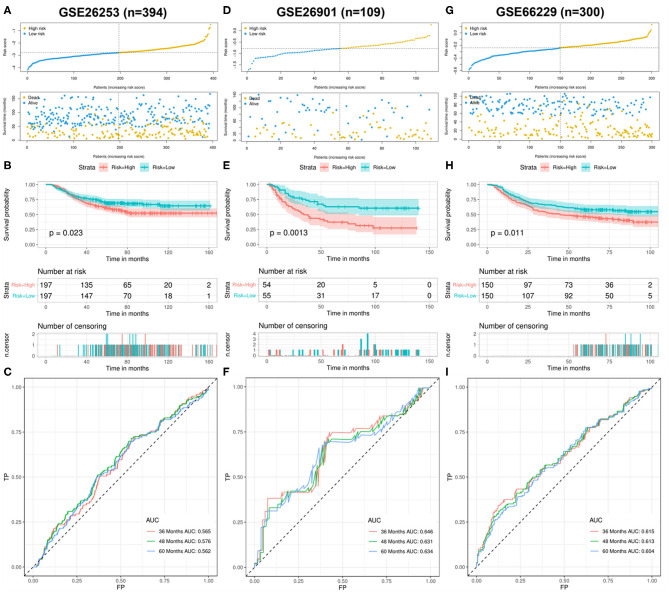
External validation of the prediction model using expression data from the GEO database as testing sets. Patients with low risk scores indicated better OS than those with high risk scores in (A–C) GSE26253, (D–F) GSE26901, and (G–I) GSE66229, which were the same as the results of the TCGA training cohort, suggesting the robust predictive capacity of the prediction model.